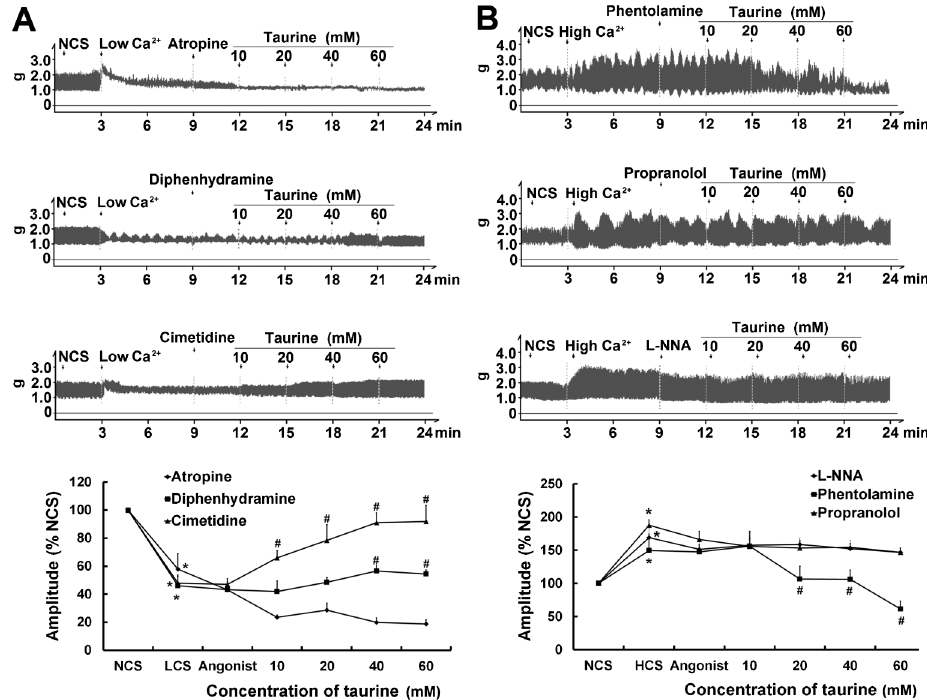
Figure 4. Effects of taurine on the contractile amplitude of isolated jejunal segments pretreated with receptor antagonists. A , Representative traces and statistical analysis (n=6) of taurine-induced effects on the contractile amplitude of isolated jejunal segments pretreated with 1 m M atropine, 10 m M diphenhydramine, and 10 m M cimetidine in low contractile states (LCS) induced by low Ca 2++ (1.25 mM) Krebs buffer. B , Representative traces and statistical analysis (n=6) of taurine-induced effects on the contractile amplitude of isolated jejunal segments pretreated with 1 m M phentolamine, 1 m M propranolol, and 300 m M L-NNA in high contractile states (HCS) induced by high Ca 2++ (5.0 mM) Krebs buffer. The contractile amplitude in the normal contractile state (NCS, control) is set to 100%; other data are the relative values compared with NCS. *P , 0.05 vs the contractile amplitude in NCS; # P , 0.05 vs the contractile amplitude in LCS or HCS before taurine administration (one-way